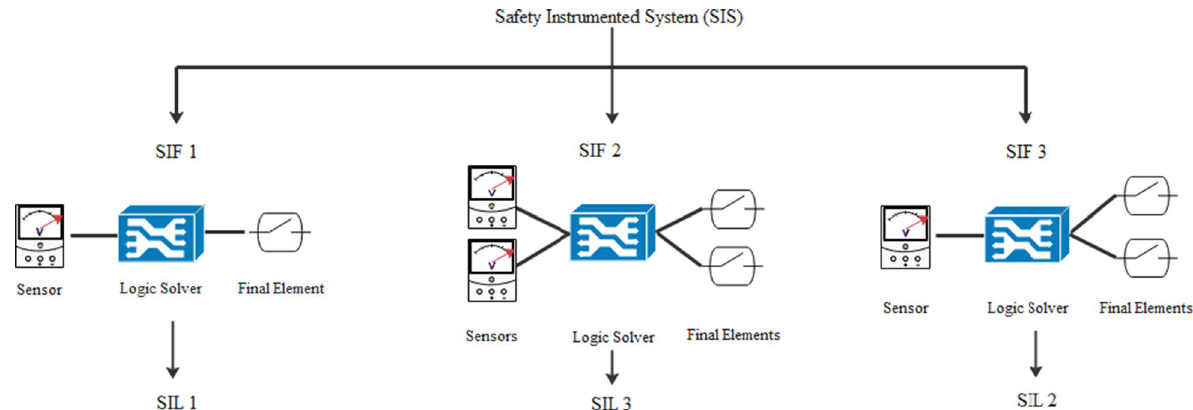
Table 3 Safety integrity levels for a safety function operating in low and high demand modes of operation, with SIL 4 having the highest level of safety integrity and SIL 1 the lowest